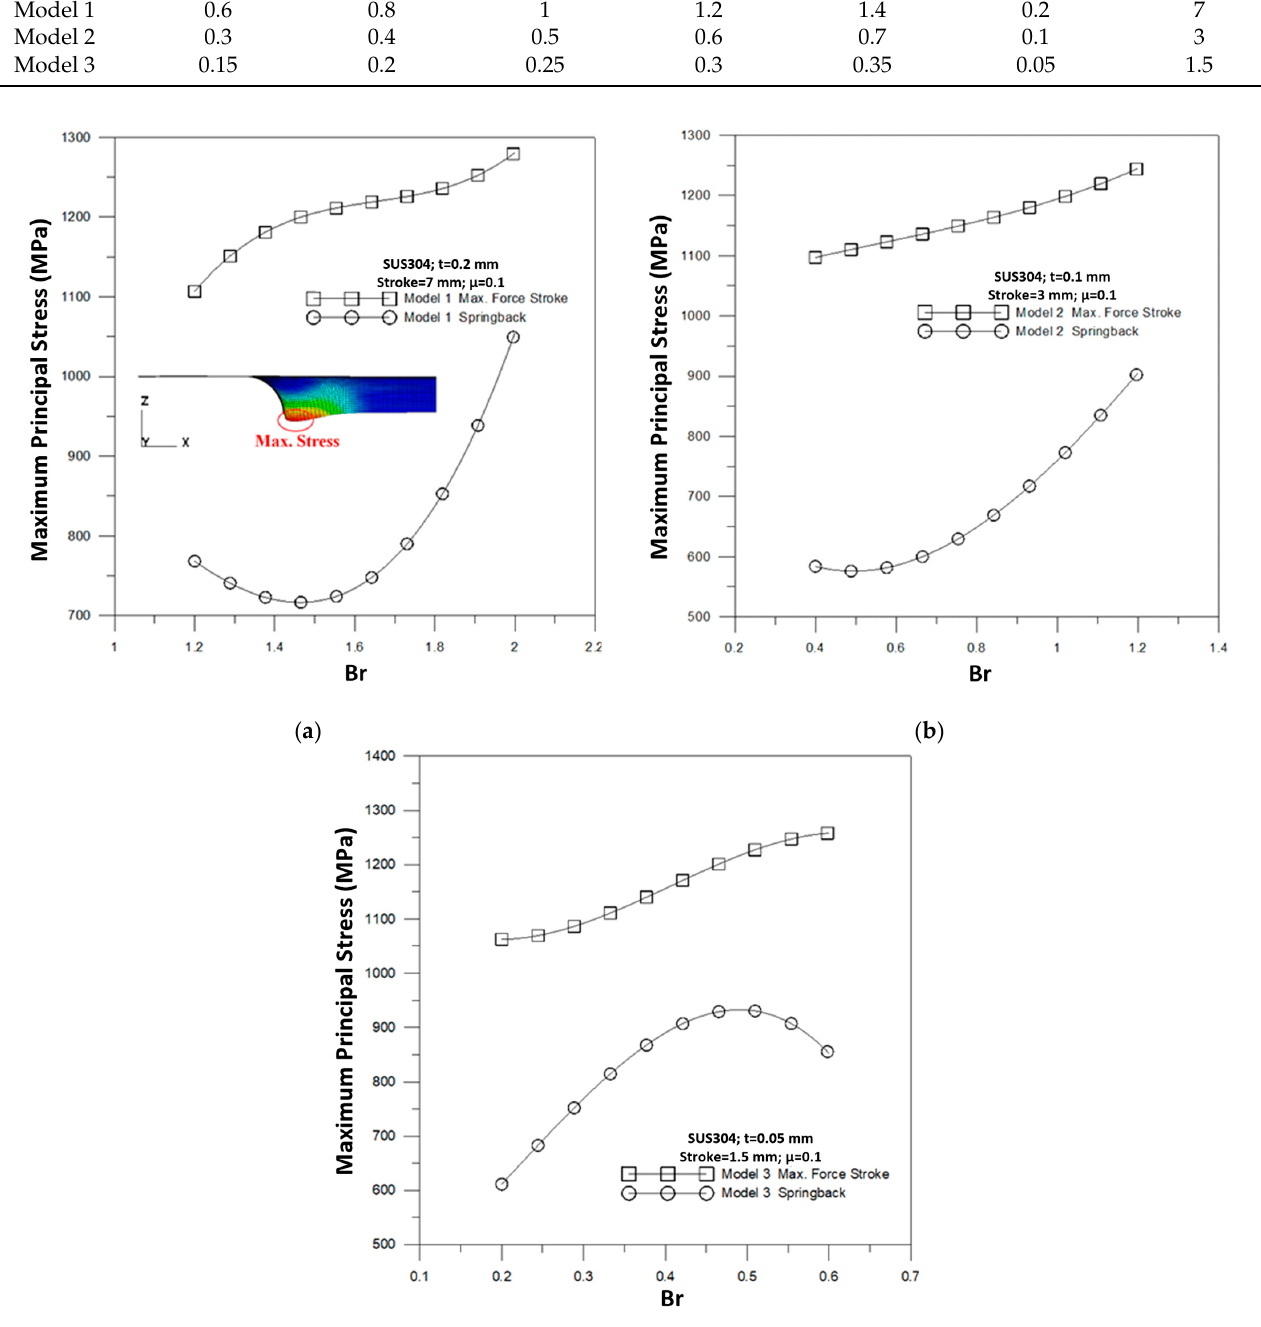
Figure 7. The relationship between the fillet radius of the hole and maximum principal stress in the material of the sheet: ( a ) Model 1; ( b ) Model 2; ( c ) Model 3.